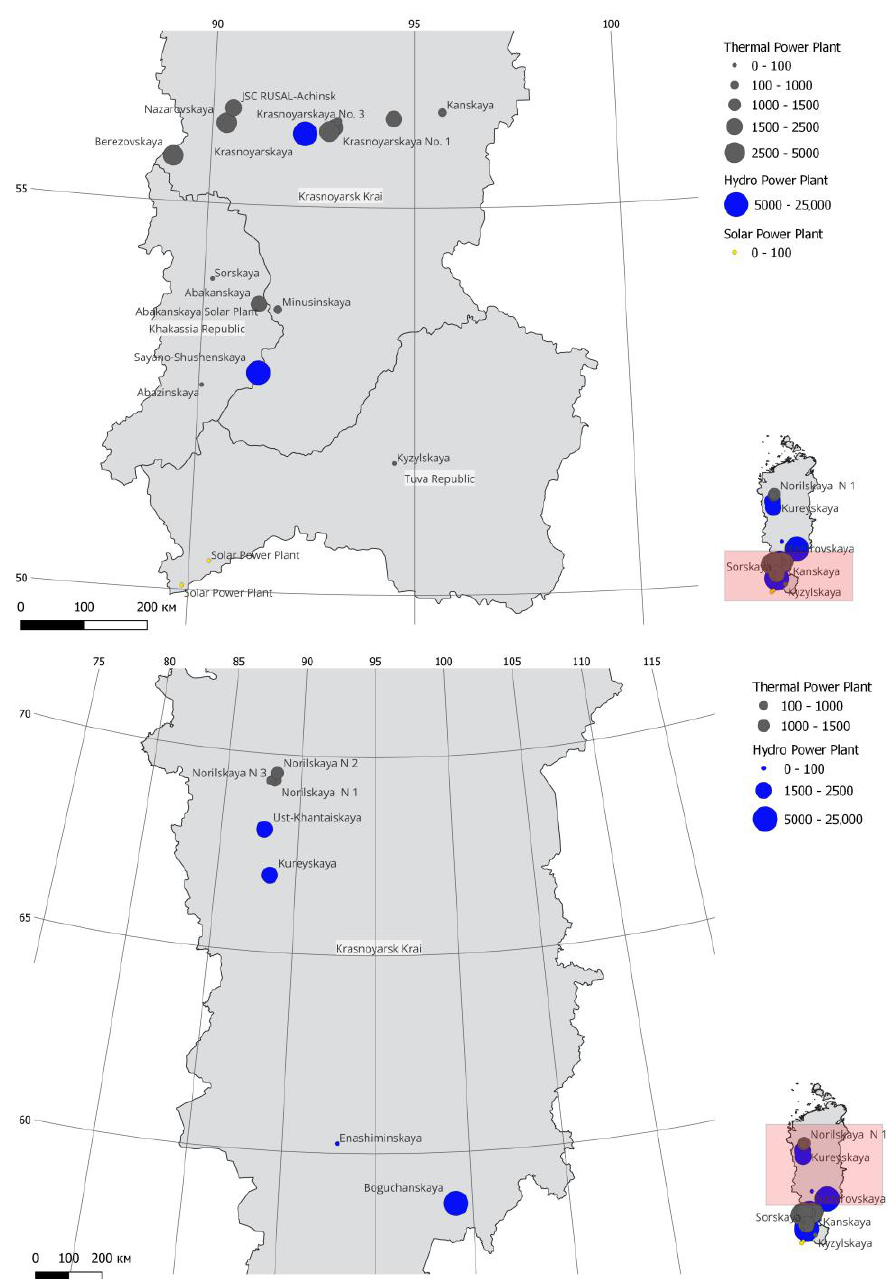
Figure 2. Electricity generation in Yenisei, Siberia, in 2020, mln kWh. Source: Schemes and Programs of Perspective Development of the Electric Power Industry of the Yenisei, Siberia, regions. Made using QGIS version 3.28. Administrative boundaries are retrieved from the Russian Geological Research Institute. URL: https://vsegei.ru (accessed on 14 November 2022).